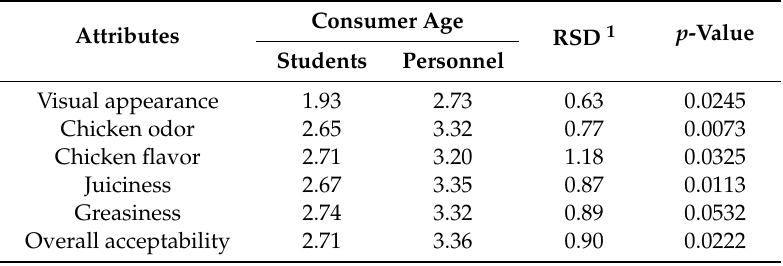
Table 7. Consumer preference analysis of leg meat according to age: Students (age < 21 years old) and personnel (age > 35 years